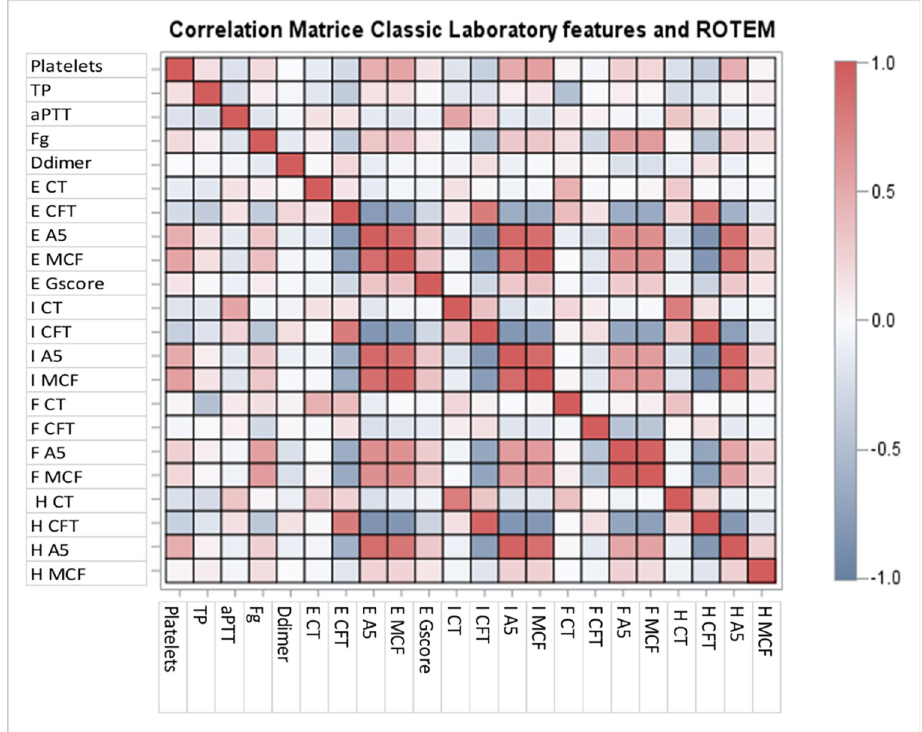
Fig 1. Matrix correlation of the indices from routine coagulation and ROTEM on admission. TP: Prothrombin Time; aPTT: Activated Partial Thromboplastin Time; Fg: Fibrinogen; E: EXTEM; I: INTEM; F: FIBTEM; H: HEPTEM; CT: Clotting time; CFT: Clot formation time; A5: Clot amplitude 5 minutes after CT; MCF: Maximum clot firmness.